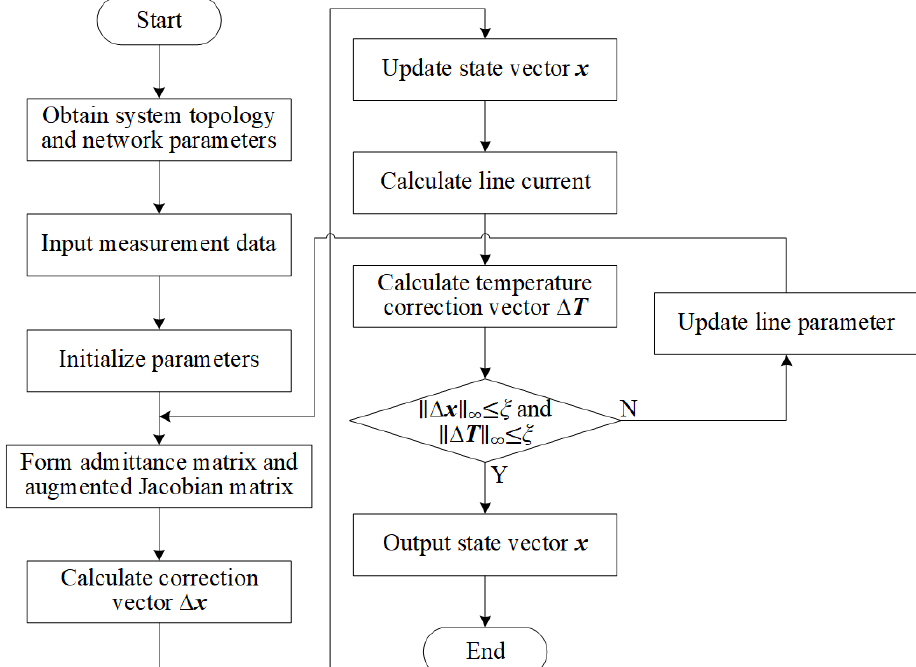
Figure 4. Flowchart of the proposed ITS-ETC-ES